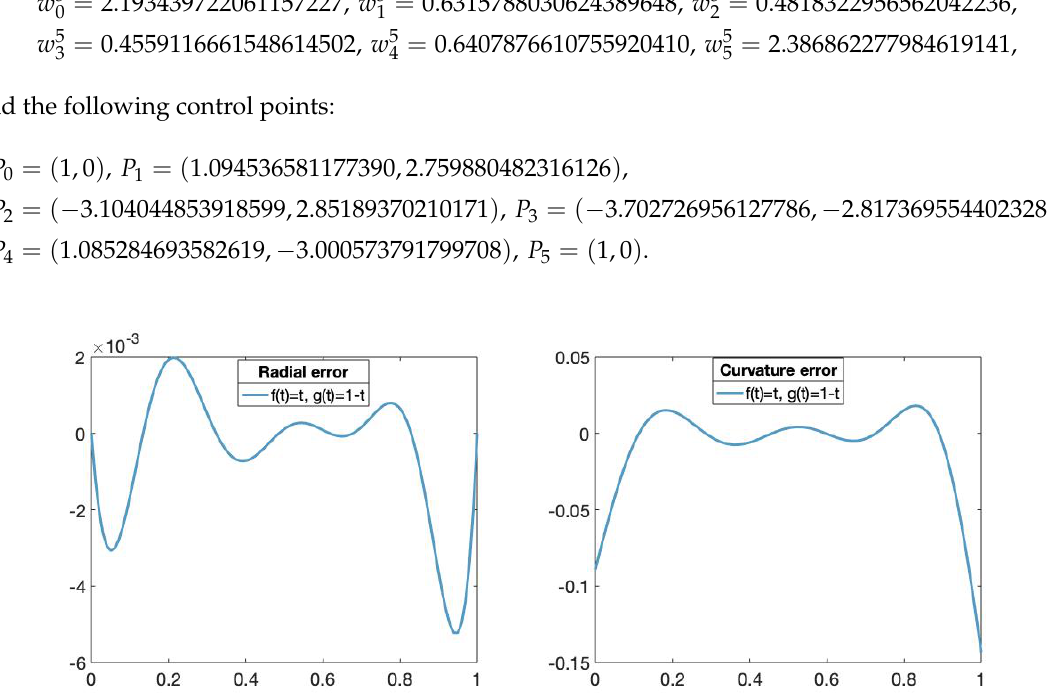
Figure 6. ( Left ): The x -axis represents the parameters t in [ 0,1 ] and the y -axis represents the radial error value of the fitting curve obtained using the functions f ( t ) = t and g ( t ) = 1 − t , t ∈ [ 0,1 ] . ( Right ): The x -axis represents the parameters t in [ 0,1 ] and the y -axis represents the curvature error value of fitting curve obtained using the functions f ( t ) = t and g ( t ) = 1 − t , t ∈ [ 0,1 ] . We can see in Figure 7 the fitting curve of degree 5 obtained and its control polygon.